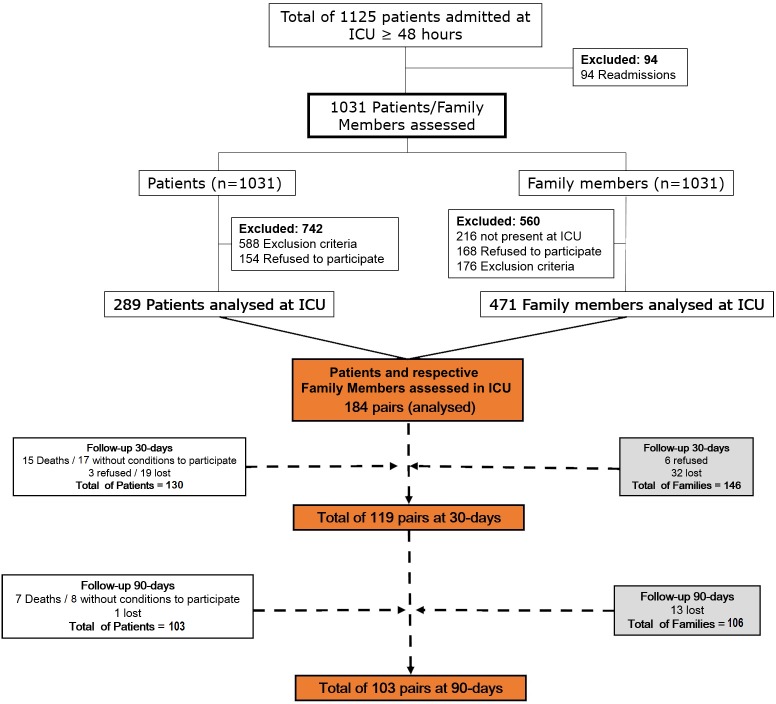
Flow chart of the study.